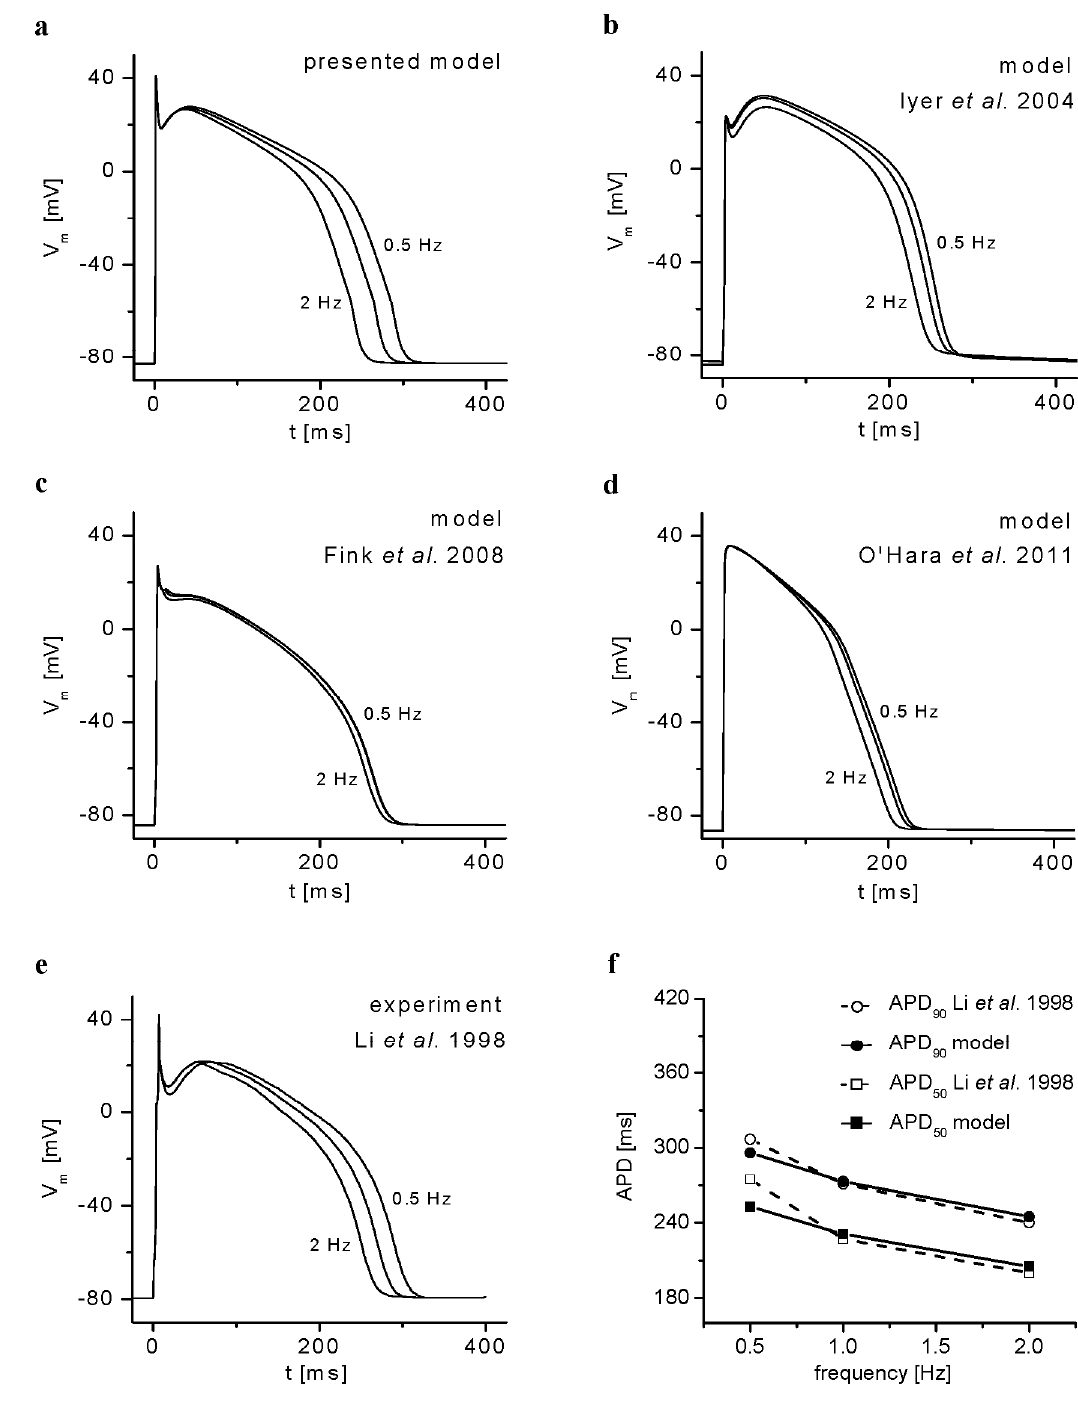
Figure 8. Comparison of model reconstructions of steady-state AP waveforms recorded at 0.5, 1 and 2 Hz stimulation in a human subepicardial cell by Li et al. [25]. The following models were used: ( a ) the present model; ( b ) the model of Iyer et al. [5]; ( c ) the model of Fink et al. [6] and ( d ) the model of O’Hara et al. [8]; ( e ) Representative AP waveforms digitized from Li et al. [25]; and ( f ) Comparison of values of APD (action potential duration at 50% and 90% repolarization, respectively) at 0.5, 1 and 2 Hz obtained from the experimental data of Li et al. [25] and the present model. In the models, 15 APs were elicited at each stimulation rate, as done in